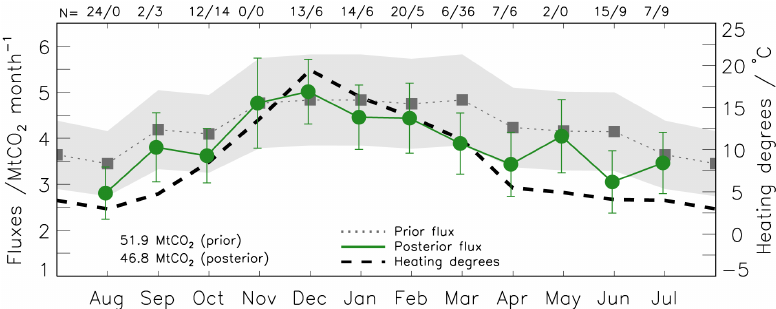
Figure 5. Results for the Lagrangian experiment (see Sect. 2.2 and Table 1). As for Fig. 3c, but a 2h time lag between downwind and upwind measurements is